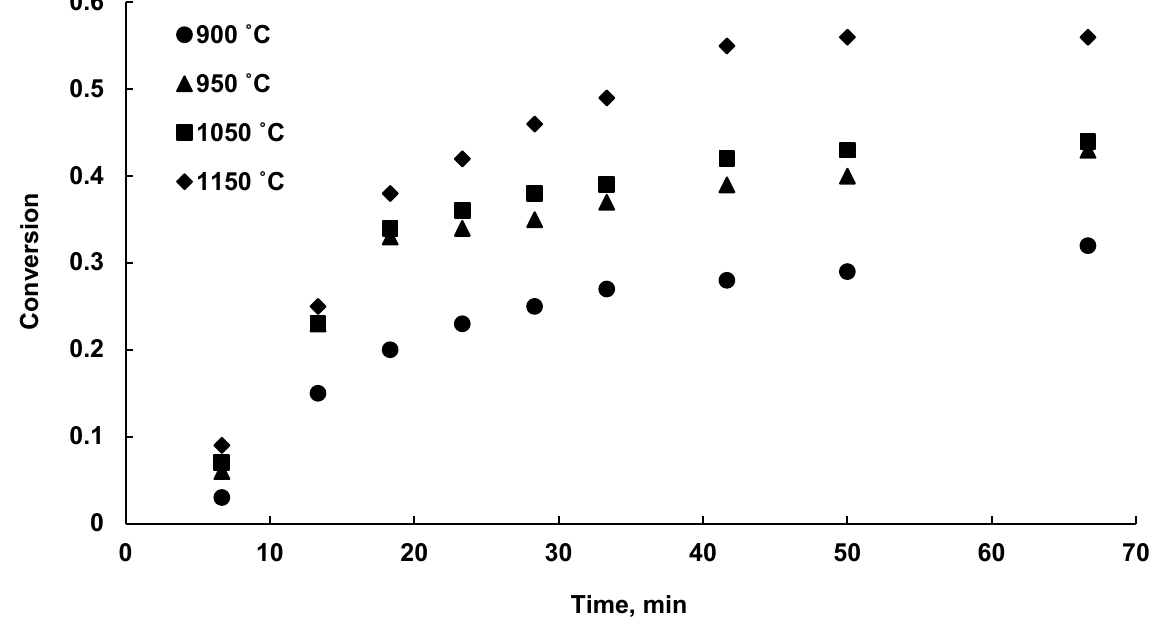
Figure 9. Conversion-time plots for the reduction of barite powder sample with brown coal.